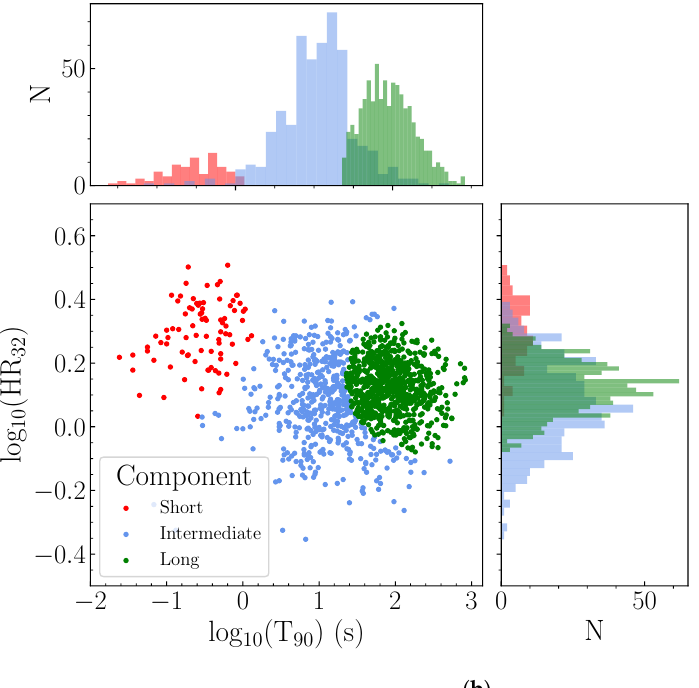
Figure 1. ( a ) BIC values of the top three MCLUST models fit to the Swift /BAT sample and ( b ) the re- sulting duration-hardness plane for the best-fit three-component model (VEI). After clustCombi was applied, the ‘intermediate’ and ‘long’ components were com- bined, producing a large decrease in entropy as shown in Figure 2. The two remaining components or classes were labelled ‘long’ and ‘short’, as shown in Figure 3. Table 2 presents the sample size of the classes.